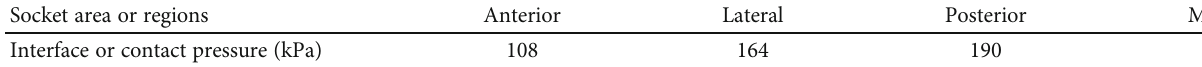
Table 3: Interface or contact pressure distribution between the socket and the patient ’ s stump.